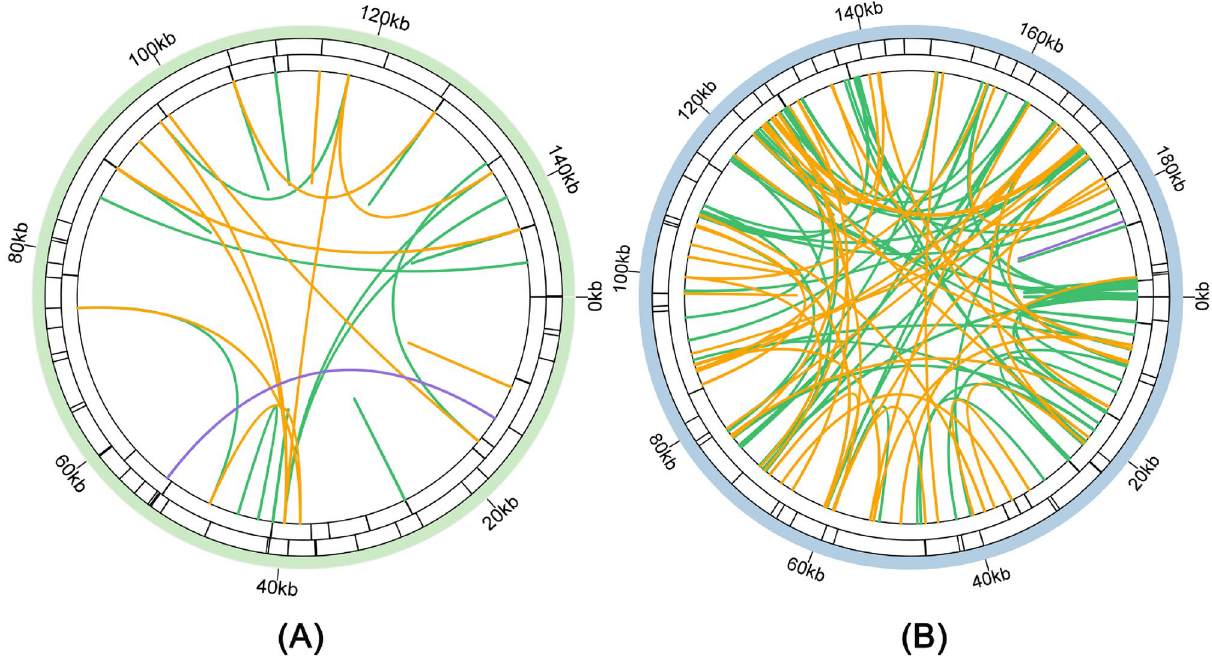
Figure 3. The repeat sequences of the A. giraldii organelle genomes. ( A ) The repeat sequences in the plastome. ( B ) The repeat sequences in the mitogenome. The first circle shows the dispersed repeats connected with green, orange, and purple arcs from the center going outward. The green, orange, and purple arcs represent the forward repeats, palindromic repeats, and reverse repeats, respectively. The next circle shows the tandem repeats as short bars. The third circle shows the microsatellite sequences as short bars. The scale is shown on the outermost circle, with intervals of 20 kb. The repeat sequences of the A. giraldii organelle genomes were visualized using the Circos package implemented in the